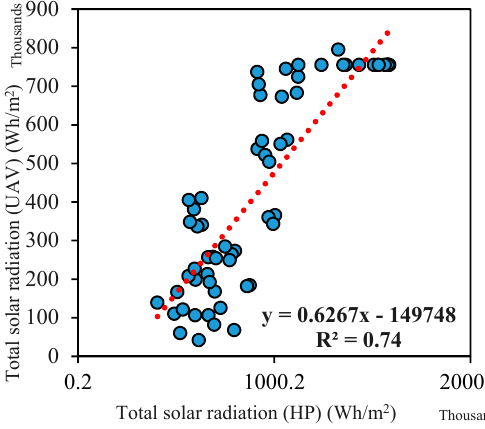
Figure 11. The correlation between the potential total solar radiation derived from HP and the UAV (64 plots) in W·h/m 2 for an entire growing season. Remote Sens. 2018 , 10 , x FOR PEER REVIEW